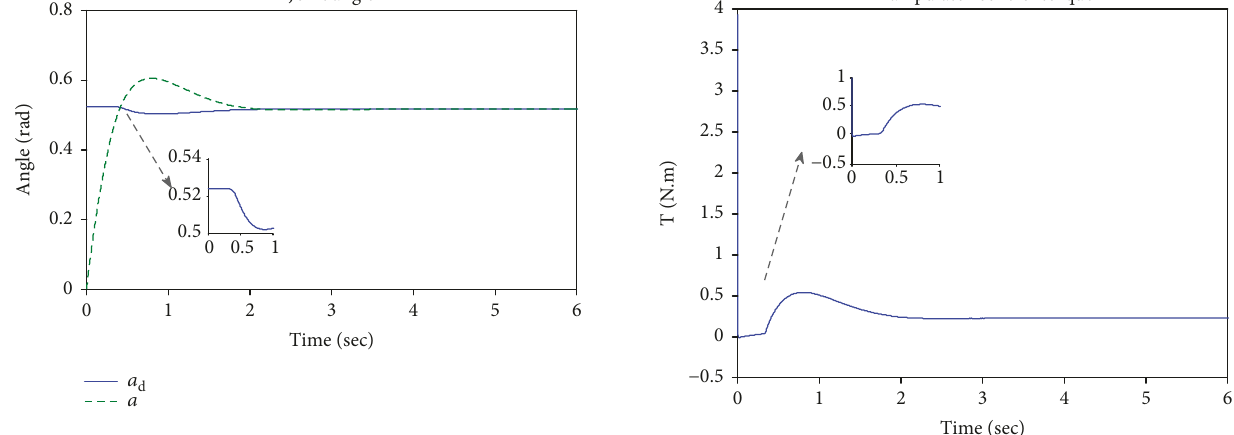
Figure 14: Desired and actual joint angle of the